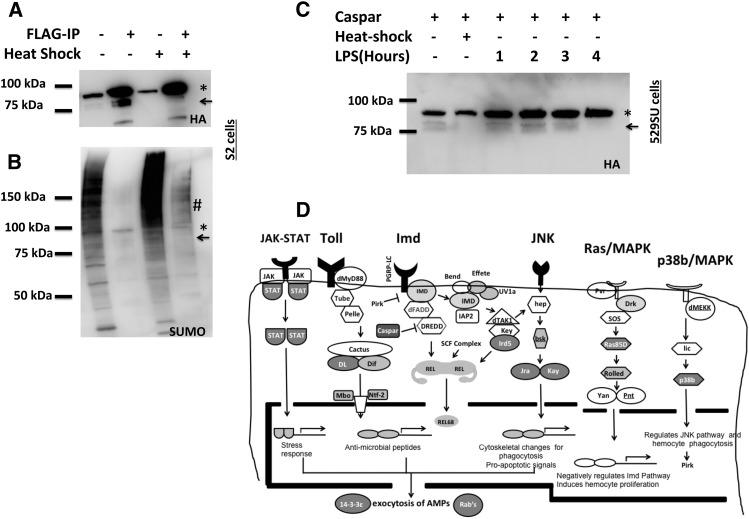
Casp is SUMOylated in cultured cells. (A) A Western blot of cellular lysates after transient expression of Casp-HA-FLAG in S2 cells shows two bands (Lane 1 and 2), a ∼80-kDa minor band (→), and a ∼95-kDa major band (*). Both bands react to anti-HA antibody and can be concentrated by anti-FLAG affinity. On heat shock (Lane 3 and 4), the lower band is not pulled down by FLAG-agarose, suggesting a transition to a SUMOylated state when cells are stressed. (B) When the blot shown in Figure 6A is probed with a SUMO antibody, it shows a characteristic ladder (Lane 1 and 4) of SUMOylated species. In the anti-FLAG affinity samples, the 95-kDa band cross reacts with the antibody, suggesting that the higher band corresponds to a SUMOylated version of Casp. As expected, a heat shock response leads to an accumulation of higher molecular weight small ubiquitin-like modifier (SUMO) species is also seen (Lane 3). The Casp affinity purification also seems to bring down other SUMOylated species (#). (C) A Western Blot, probed with anti-HA antibody showing the response of cells to LPS. Casp-HA-FLAG is transiently expressed in 529SU cells and the immune response initiated by the addition of 10 μg/mL lipopolysaccharide (LPS). The major Casp band corresponds to a SUMOylated species (95 kDa), with the non-SUMOylated species (80 kDa, →) decreasing with increasing time post-LPS treatment. (D) SUMOylated proteins can act as dynamic regulation points in immune signaling. This figure summarizes the current status of proteins regulated by SUMO in Drosophila immune response. The Tl, immune-deficient (IMD), Jun kinase (JNK), mitogen-activated protein kinase (MAPK), and Janus kinase/signal transducers and activators of transcription (JAK-STAT) pathways appear to have at least one control point for SUMO-mediated regulation. Proteins labeled in white, within dark gray boxes, have been demonstrated to be SUMOylated in this and previous studies. Proteins labeled in black, in light gray boxes, are potential targets that need further validation.